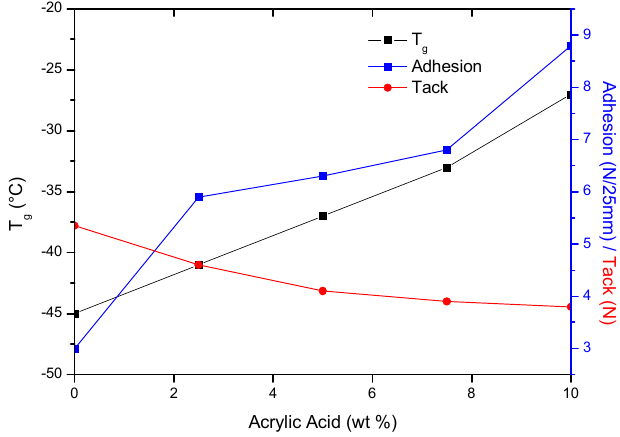
Materials 2020 , 13 , x FOR PEER REVIEW Figure 7. Adhesion, tack and T g of PSAs as a function of AA content. Figure 7. Adhesion, tack and T g of PSAs as a function of AA content.